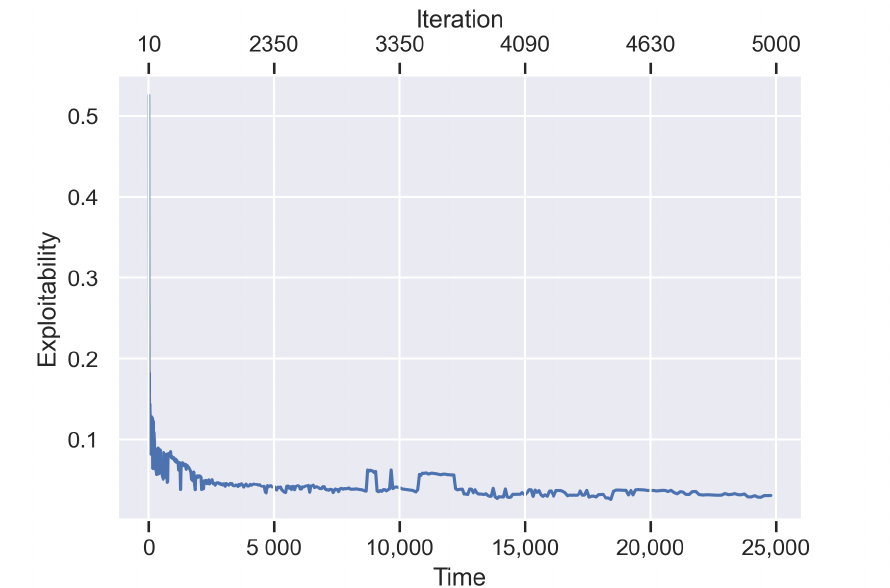
Figure 1. Exploitability ( (cid:101) ) vs. runtime (seconds) and algorithm iteration for continuous imperfect- information Blotto